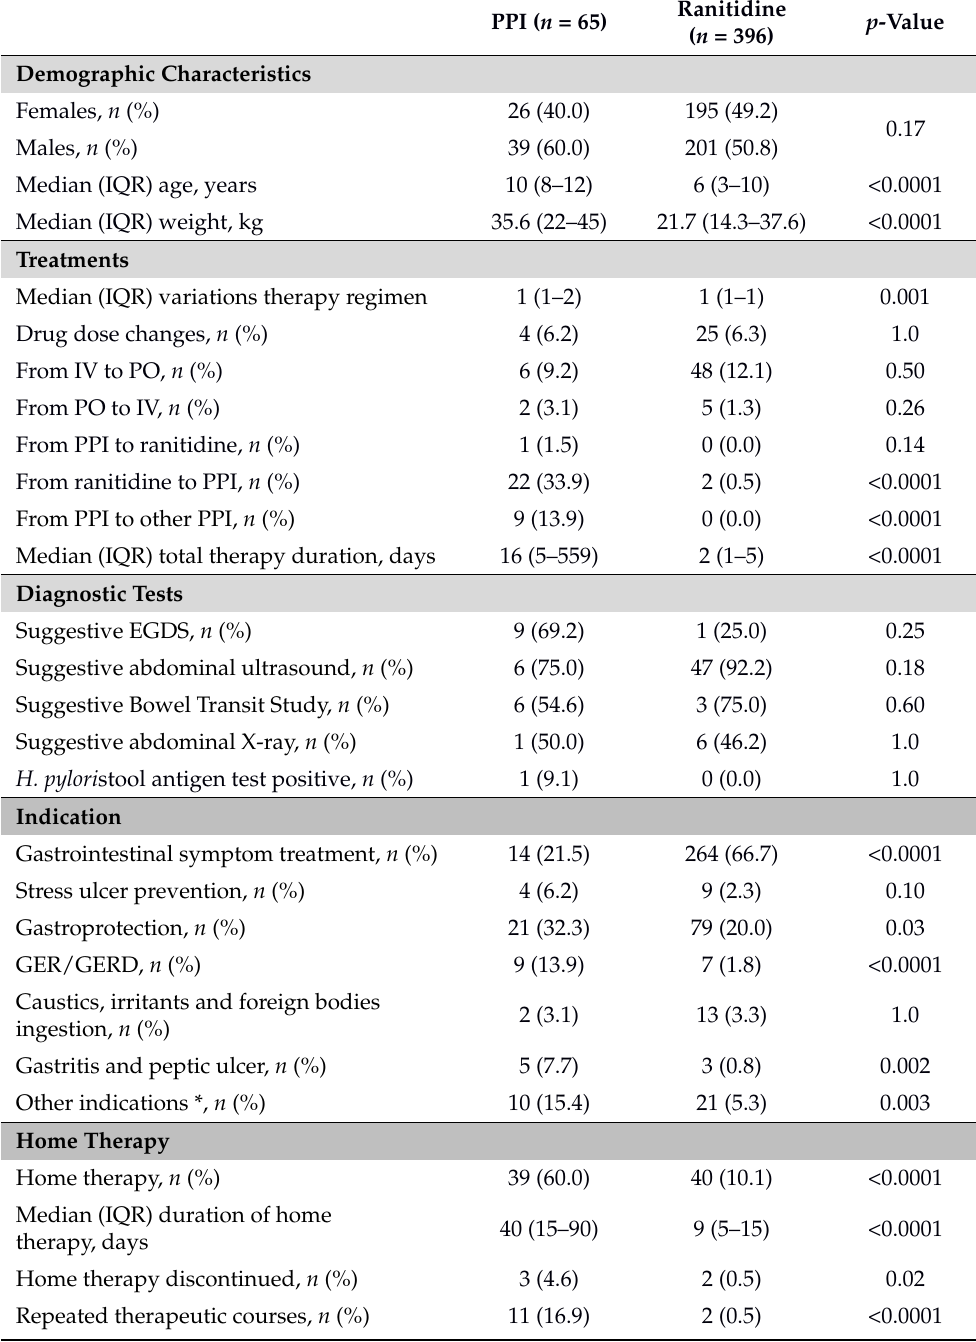
Table 3. Demographic clinical and treatment characteristics of the study population, stratified by treatment